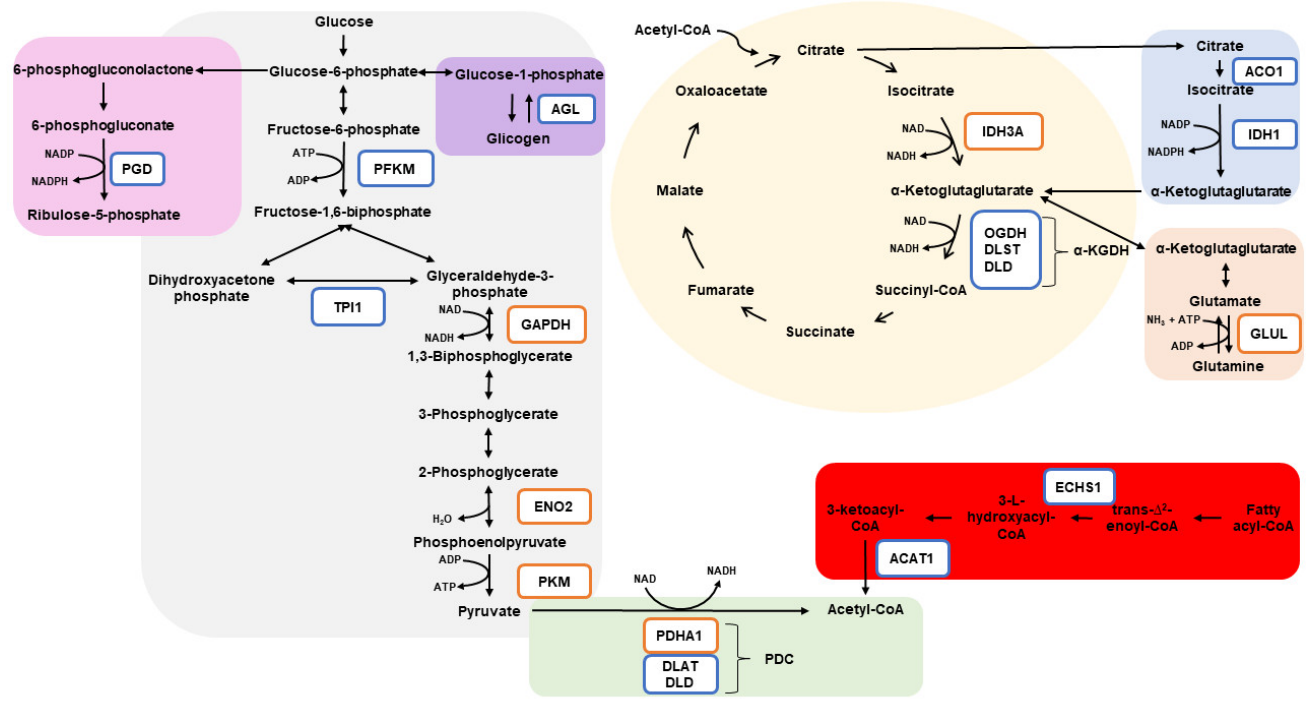
Figure 4. Summarized metabolic pathways influenced by the experimental treatments. Glycolysis is represented in gray, glycogenolysis in purple, pentose phosphate pathway in pink, oxidative decarboxylation of pyruvate to form acetyl-CoA in green, citrate cycle in yellow, cytoplasmic conversion of citrate into α -ketoglutarate in blue, glutamine synthesis in orange, and fatty acid degradation in red. Proteins inside orange squares were exclusively expressed in MR or were more abundant in MR compared to RM. Proteins inside blue squares were exclusively expressed in RM or were more abundant in RM compared to MR. α-KGDH: α- ketoglutarate dehydrogenase complex; ACAT1: acetoacetyl-CoA thiolase; ACO1: aconitase 1; AGL: glycogen debranching enzyme; DLAT: dihy- drolipoyl transacetylase; DLD: dihydrolipoamide dehydrogenase; DLST: dihydrolipoyllysine-resi- due succinyltransferase; ECHS1: enoyl CoA hydratase, short chain 1; ENO2: enolase 2; GAPDH: glyceraldehyde-3-phosphate dehydrogenase; GLUL: glutamine synthetase; IDH1: isocitrate dehy- drogenase 1; IDH3A: isocitrate dehydrogenase 3 catalytic subunit alpha; OGDH: 2-oxoglutarate de- hydrogenase; PDC: pyruvate dehydrogenase complex; PDHA1: pyruvate dehydrogenase E1 subu- nit alpha 1; PFKM: phosphofructokinase; PGD: 6-phosphogluconate dehydrogenase; PKM: py- ruvate kinase; TPI1: triosephosphate isomerase.